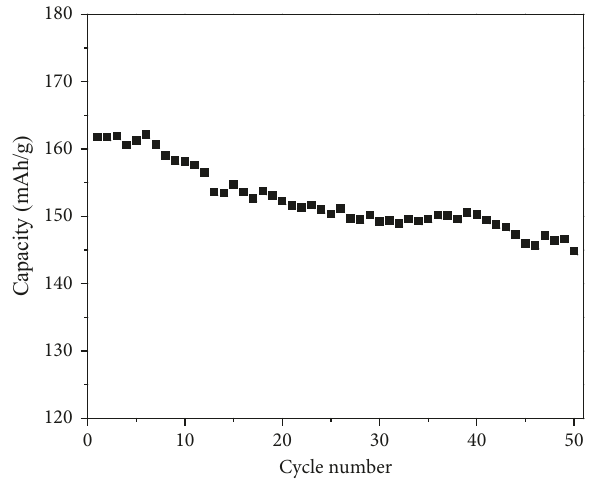
Figure 6: The cyclic performance at a current of 0.1 C of LiNi 1/3 Co 1/3 Mn 1/3 O 2 powder prepared at 750 °